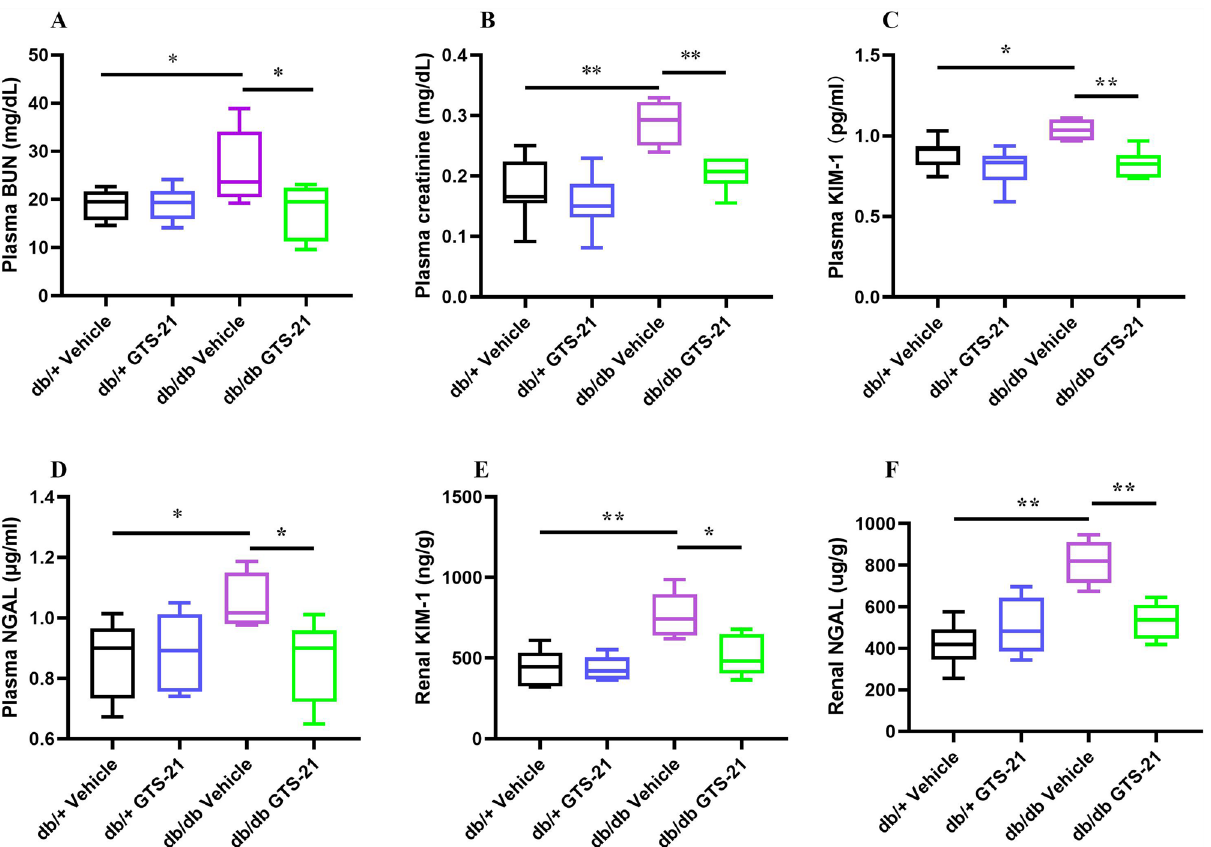
Figure 1. Effects of GTS-21 on renal function and injury. All mice received GTS-21 (4 mg/kg, IP, B.I.D.) or vehicle for 8 weeks. Plasma and tissue samples from kidney were collected for measuring plasma BUN ( A ) plasma creatinine ( B ), plasma KIM-1 ( C ), plasma NGAL ( D ) and renal KIM-1 ( E ) and renal NGAL ( F ) using ELISA. The data is represented as mean ± SE (n = 5–9/group), * P < 0.05, ** P <